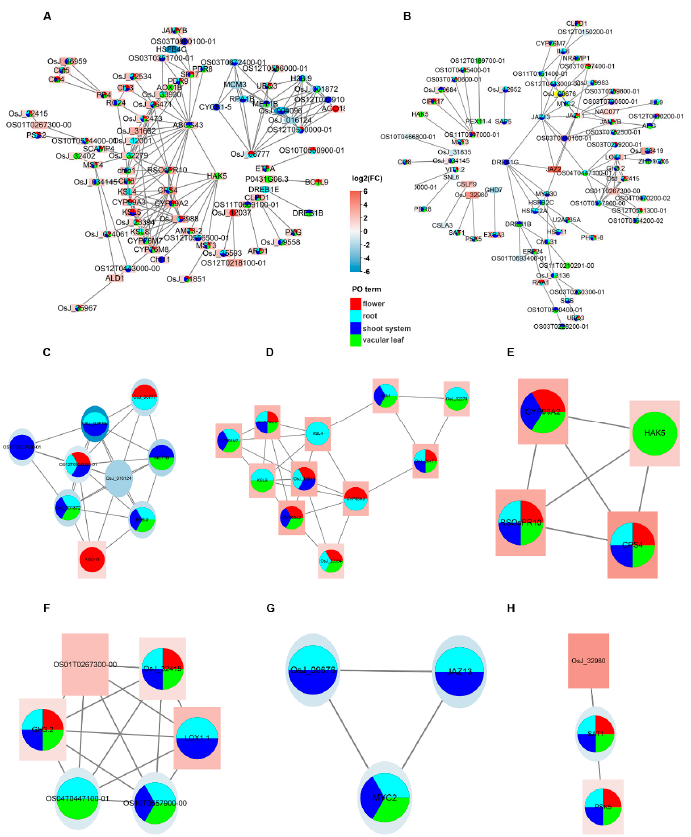
Figure 5. Protein–protein interaction network analysis of DEGs. ( A ) Protein–protein interaction networks generated by DEGs from OsCBL8 and ( B ) OsCIPK17 overexpression lines. The up- (square, red) and downregulated (round, blue) genes form two clusters, which are distinguished by different shapes and colored with log2(FC). Different PO terms are also mapped to proteins. ( C , D ) and ( E ) Sub-modules mined by MCODE from OsCBL8 overexpression lines. According to the score, the top three are shown. The scores of them were 6.75, 5.2 and 4, respectively. ( F – H ) Sub-modules mined by MCODE from OsCIPK17 overexpression lines. According to the score, the top three are shown. The scores of them were 6, 3 and 3, respectively. There were six nodes and fifteen interactions in sub-module 1 (Figure 5F) in the Os- CIPK17 overexpression line, and they were enriched in the four selected PO terms. Four nodes were upregulated and two were downregulated. Among them, LOX1.1 and